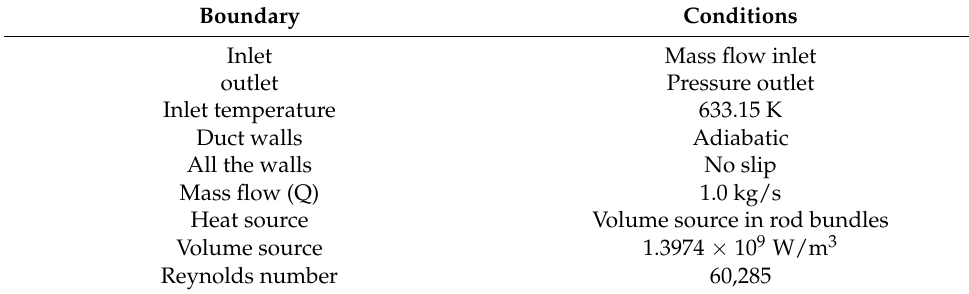
Table 2. Boundary Table 2. Boundary conditions.